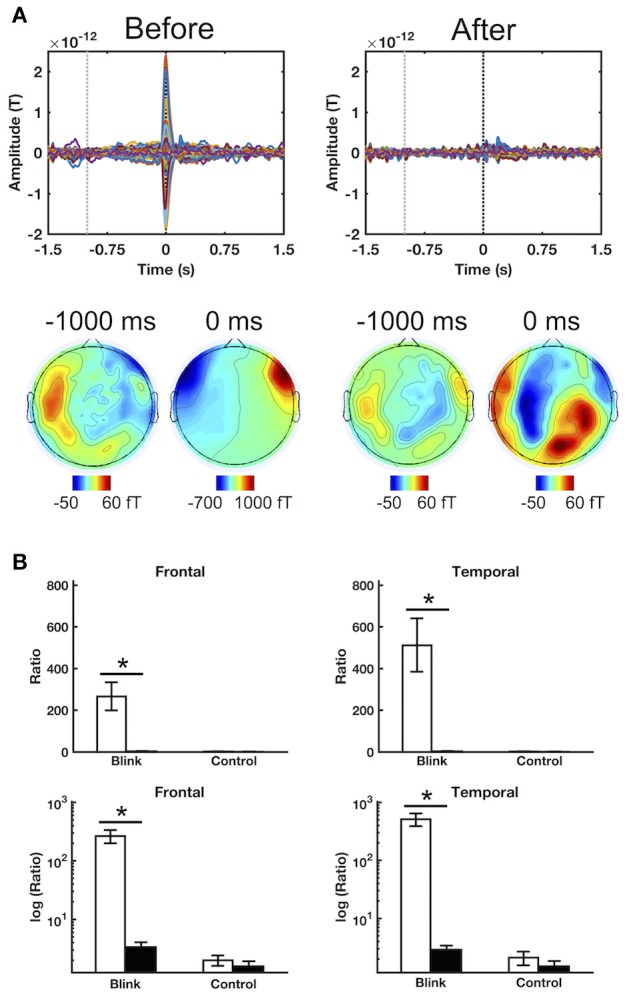
Sample results illustrating the efficacy of ICA artifact rejection. (A) ERFs for a representative subject before and after ICA artifact rejection. Top row shows time courses for all channels, while bottom row presents spatial topographies at the corresponding latencies. Black and gray dotted lines denote 0 ms (T0) and –1,000 ms latencies, respectively. (B) Regional blink-to-baseline power ratios before and after artifact rejection in the frontal and temporal channels where ocular artifact tends to be greatest. Top row shows raw power ratio values, in which the extreme discrepancy between the blink and control conditions led to obscuring of the control condition outcomes during display. The bottom row shows power ratios in logarithmic scale to improve display clarity. The ratios were computed for each subject and presented as mean ± SE across subjects. Statistical comparison was performed using raw, untransformed values. *p < 0.005.